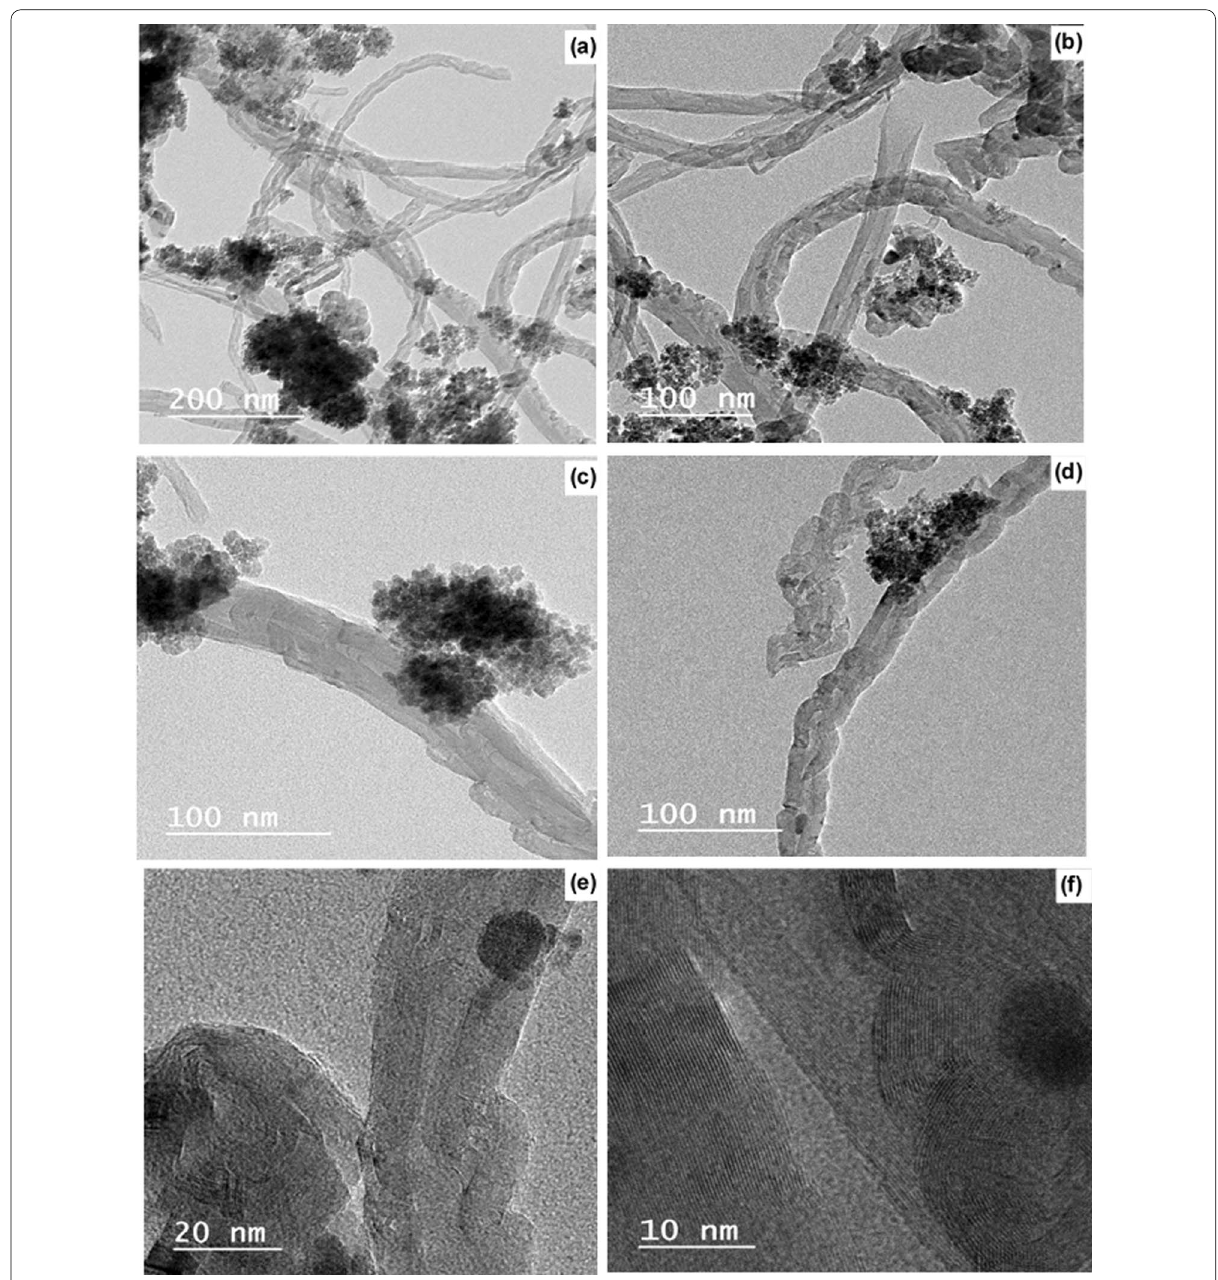
Fig. 5 HRTEM images of MWCNTs-PEG-Ixazomib showing ixazomib citrate into and on the walls of